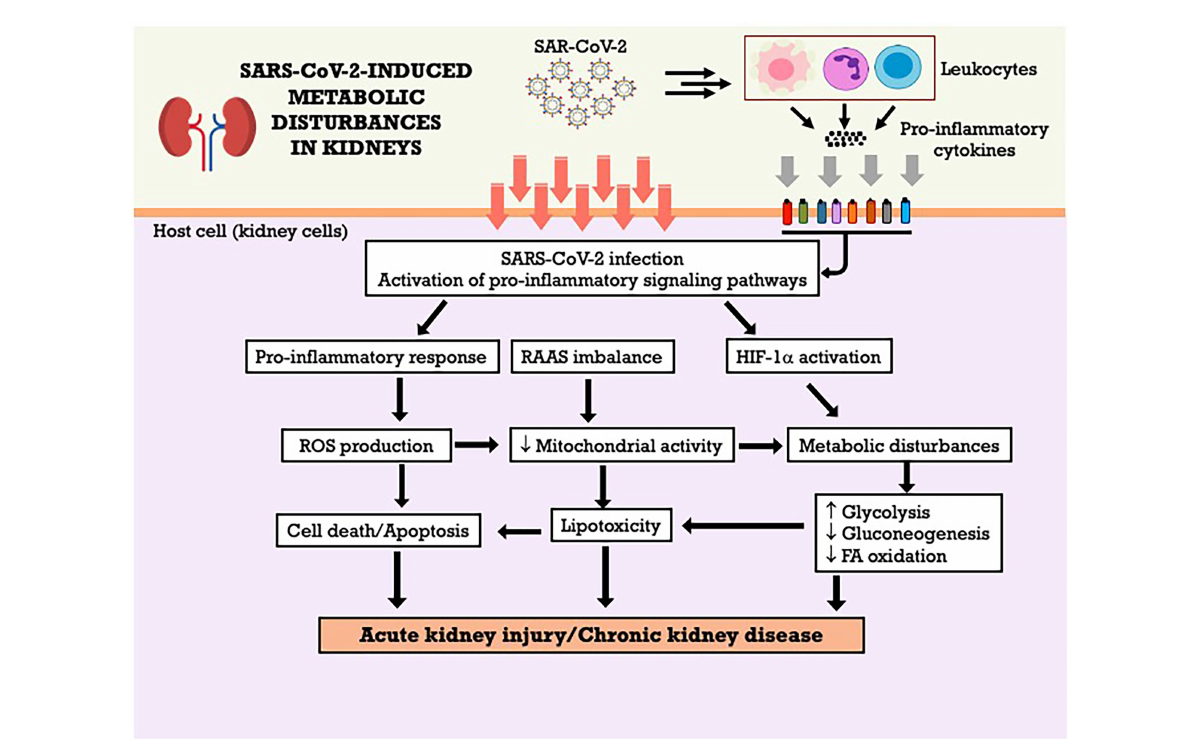
FIGURE 3 SARS-CoV-2-induced metabolic disturbances in kidneys. FA, fatty acid; HIF-1 α , hypoxia-inducible factor-1 alpha; RAAS, renin-angiotensin- aldosterone system; ROS, reactive oxygen